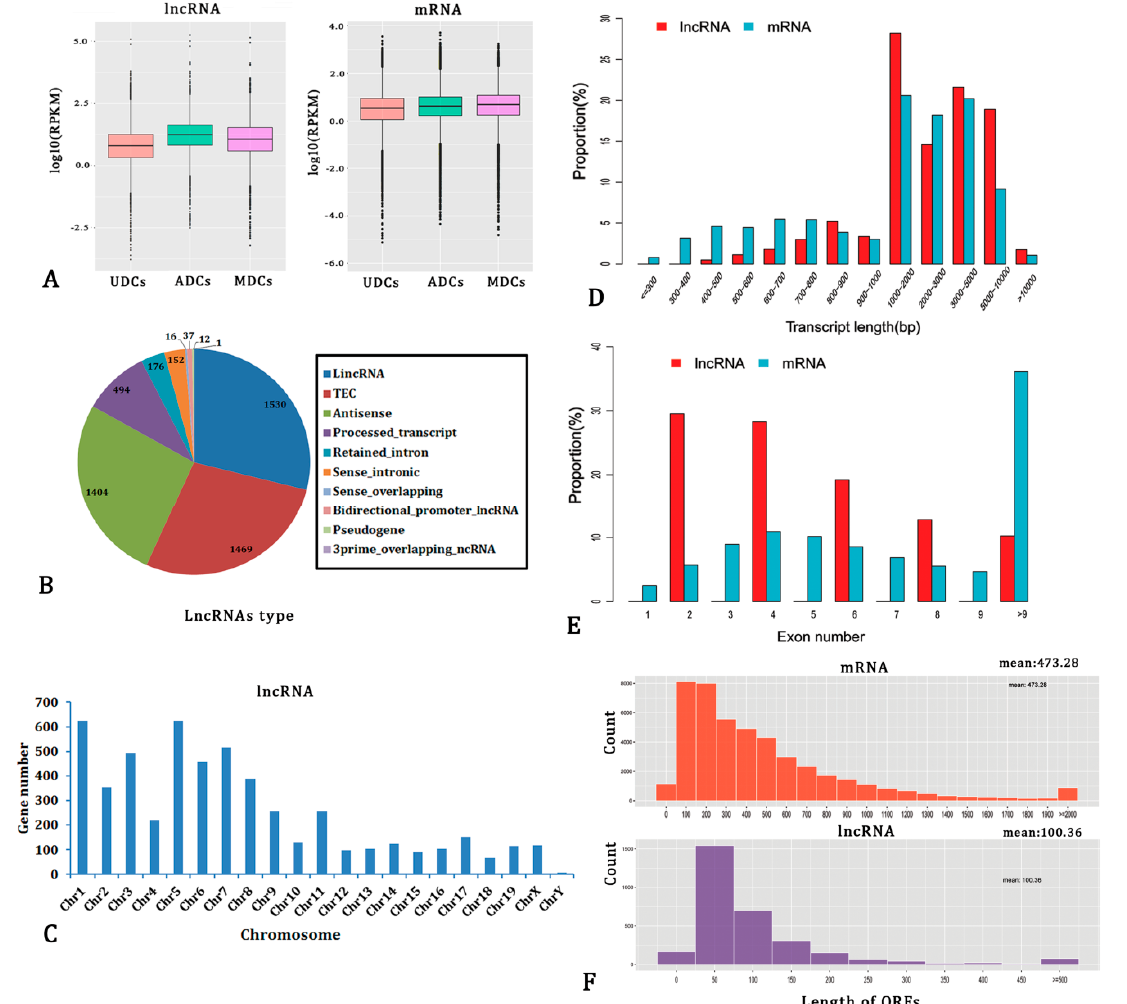
Figure 2. The features of long non-coding RNA (lncRNAs) and mRNAs. ( A ) The FPKM distribution of all identified lncRNAs and mRNAs at three different cells. ( B ) Percentage of different types of lncRNAs. ( C ) Distribution of lncRNA transcripts along each chromosome. ( D ) Transcript size distribution of lncRNAs and mRNAs. ( E ) Exon number per transcript of lncRNAs and mRNAs. ( F ) Distribution of the open reading frame (ORF) length of lncRNAs and mRNAs.